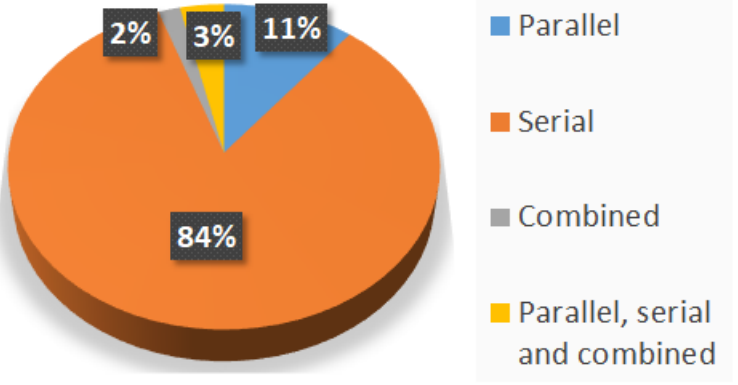
Figure 3. Percentage share of types of GB sensors, i.e., parallel, serial and